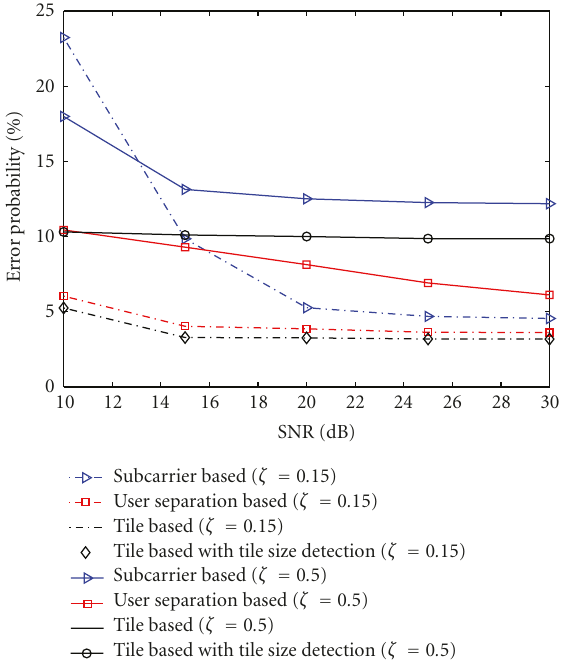
Figure 9: Error probability in detecting the spectrum opportunities using four di ff erent methods for a resource block size of 4 × 3.